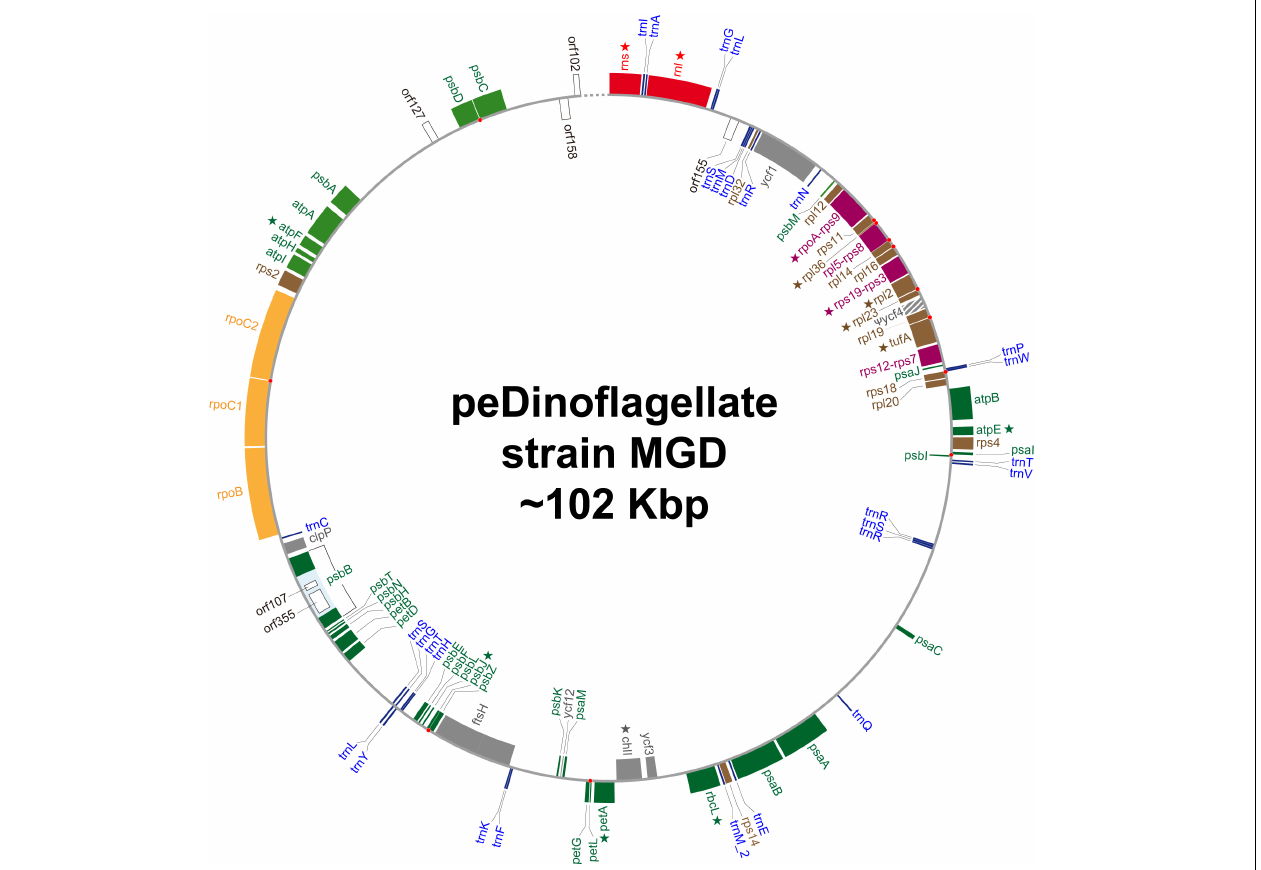
FIGURE 3 | Circular map of the plastid genome of the peDinoflagellate strain MGD. The details of this figure are the same as Figure 1 . ycf4 in the MGD genome is considered as a pseudogene. The precise nucleotide sequence between orf102 and rns , which is indicated by a dotted line in this figure, could not be determined because of repeat sequences. Star indicates the genes of which transcripts receive RNA